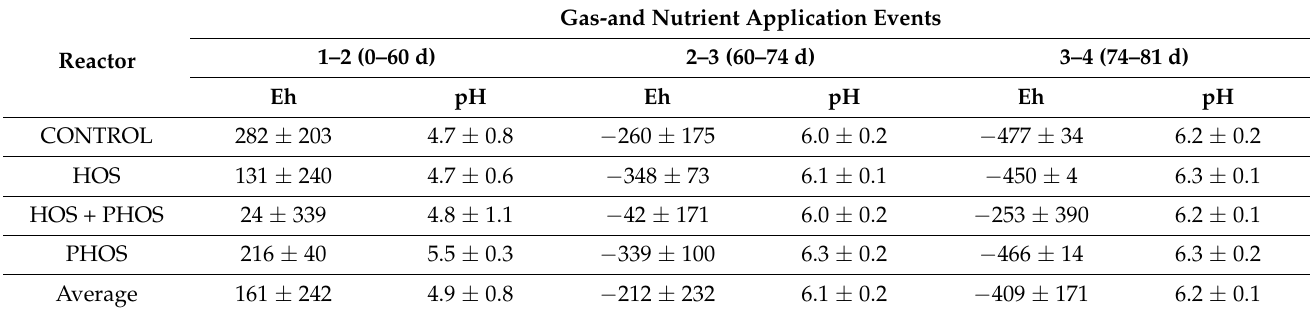
Table 5. Variations in Eh and pH values in experimental